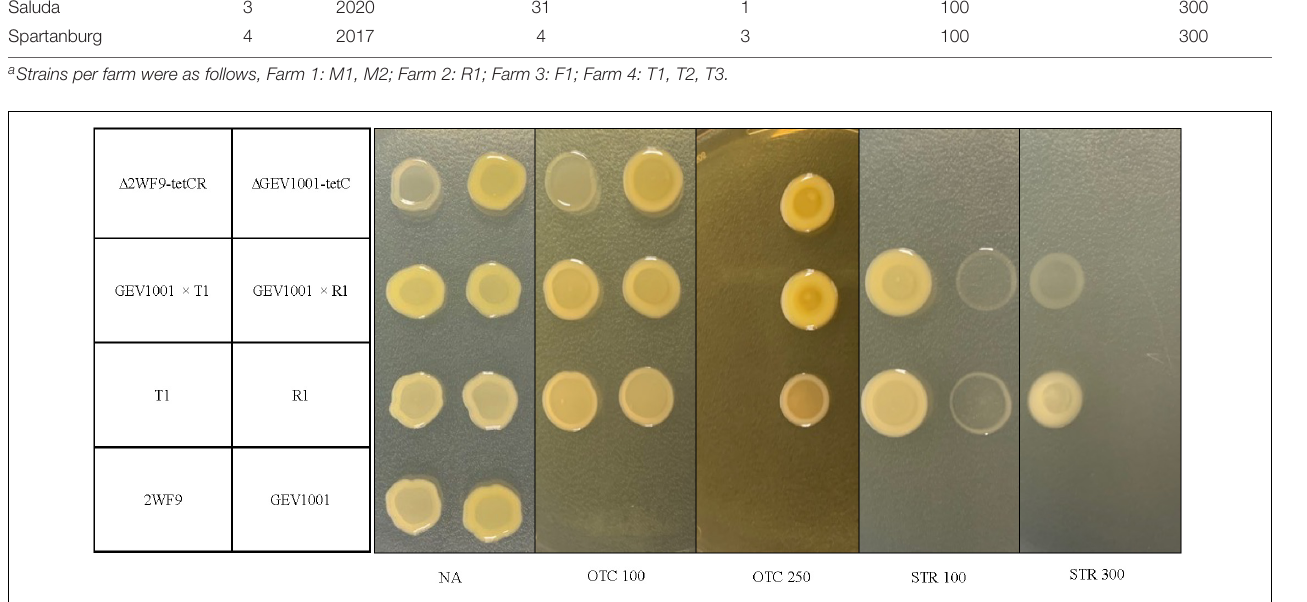
OTC resistance Strains a threshold (ppm)